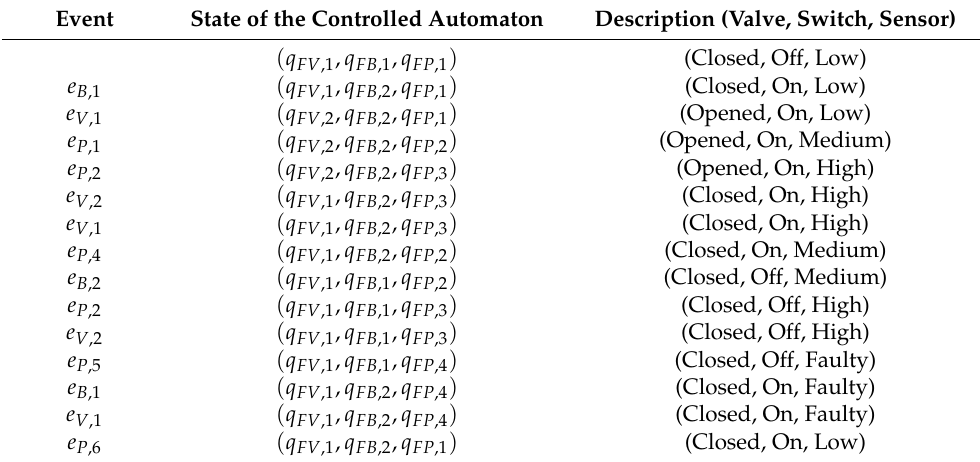
Table 2. Simulation of the controlled automaton.